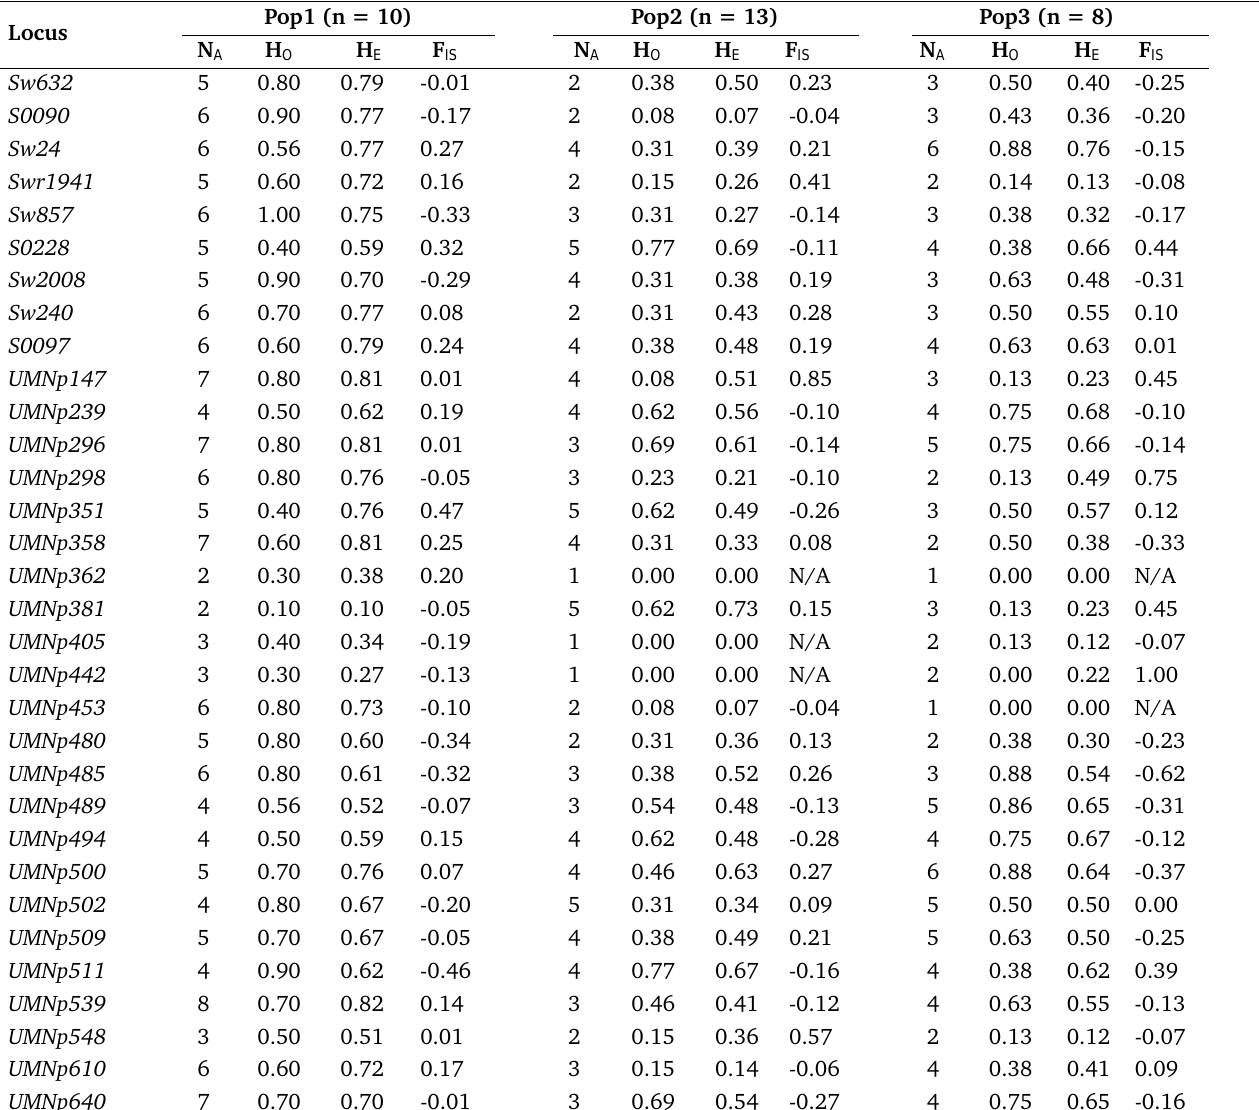
Table 2. Polymorphism measurements of microsatellite loci of each sampled population. n = No. samples, N A = No. alleles, H O = observed heterozygosity, H E = heterozygosity, F IS = breeding coefficient Locus